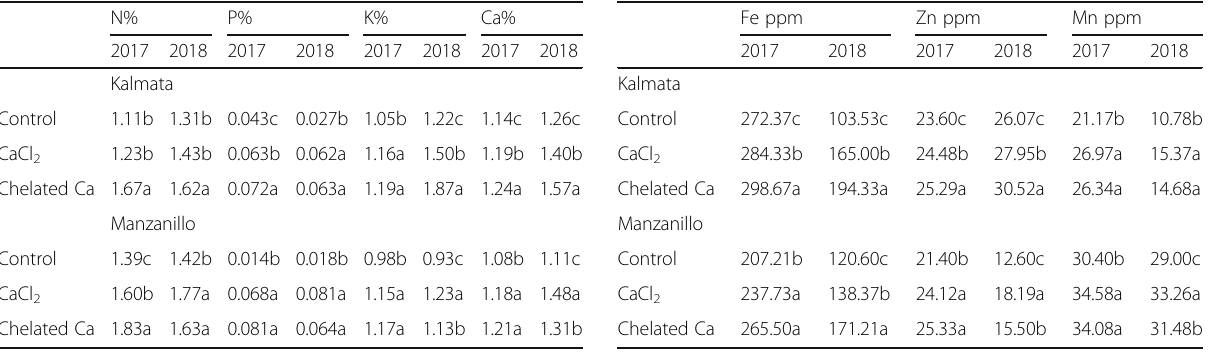
Table 5 Effect of foliar spray with some calcium sources on iron (Fe), zinc (Zn), and manganese (Mn) contents in leaves of olive Kalmata and Manzanillo